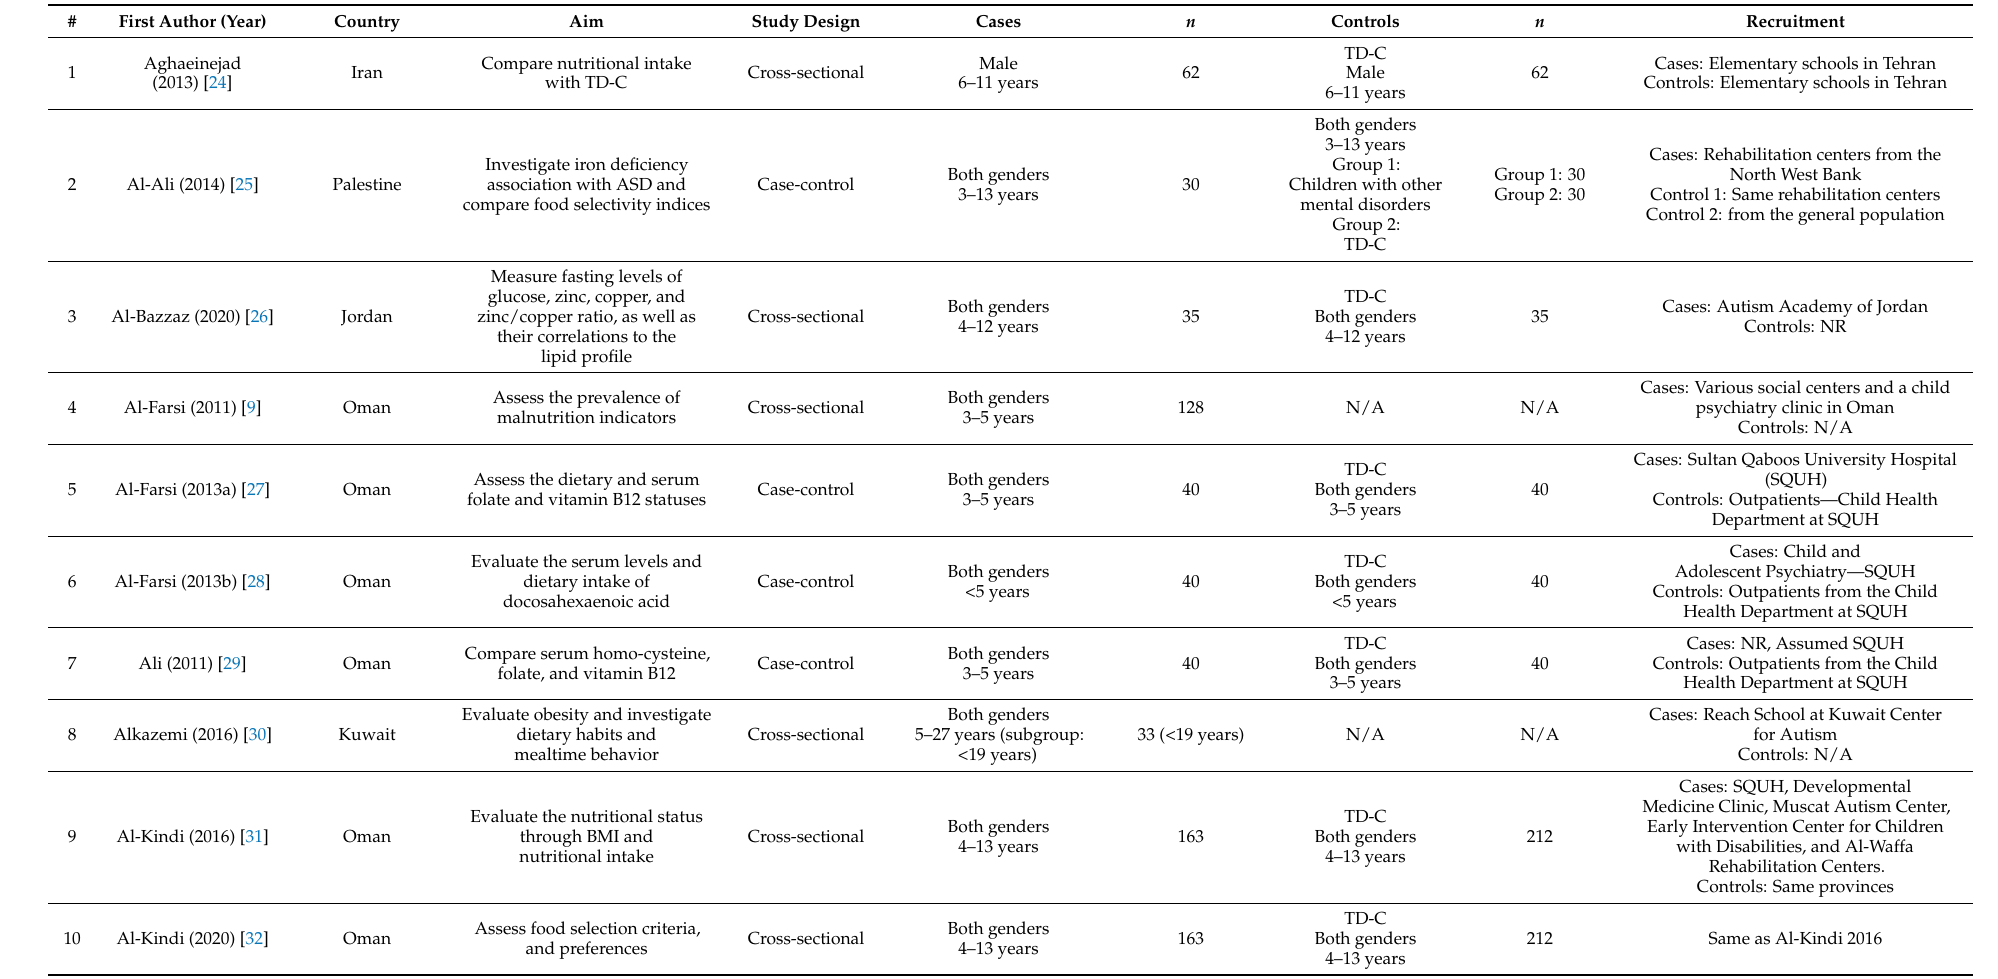
Table 2. Characteristics of studies selected on children with autism spectrum disorder in the MENA